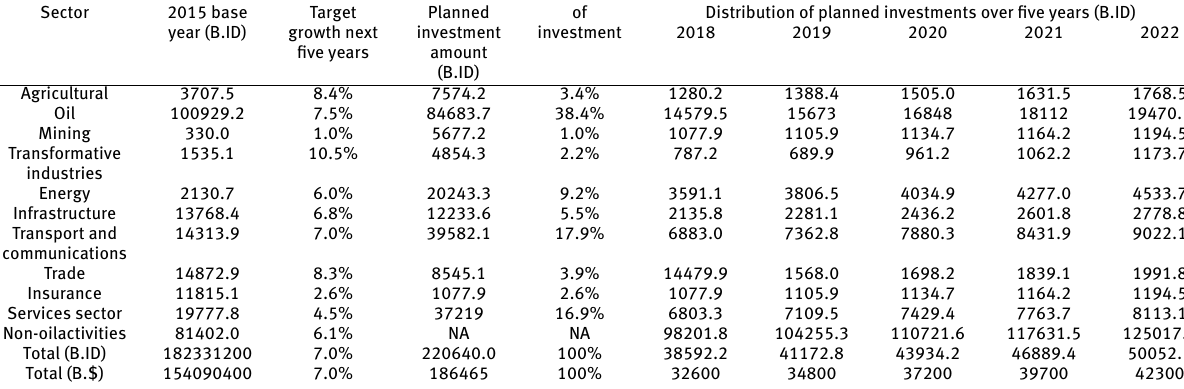
Table 5: Target Growth Rates of Investments in National Economic Sectors from 2018 to 2022* Sector